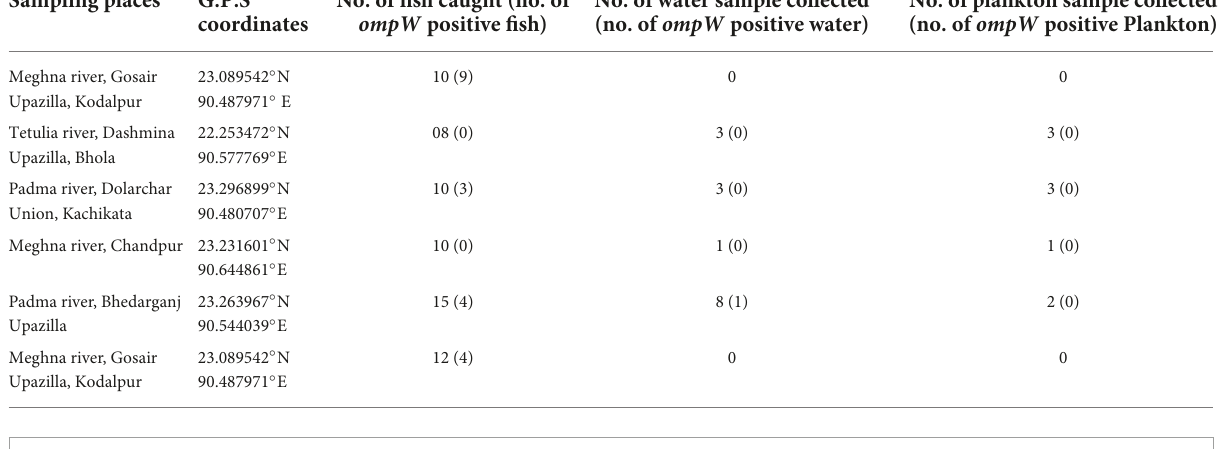
TABLE 1 Sampling locations and number of collected fish, water, and plankton samples in the presence (%) of the ompW gene. Sampling places